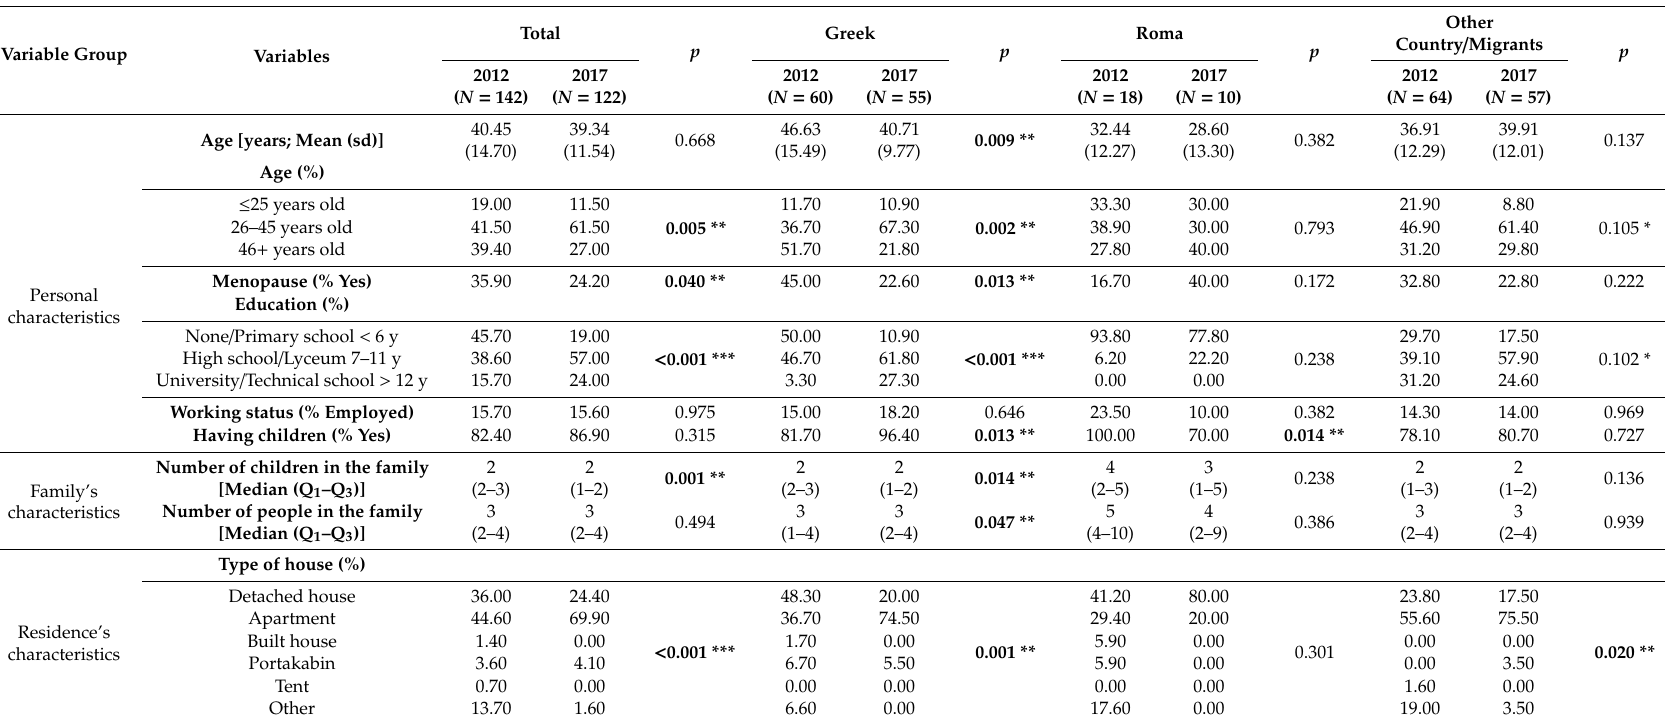
Table 1. Personal, family and residence characteristics separately for each study period for the total sample of participating women in the and by nationality.